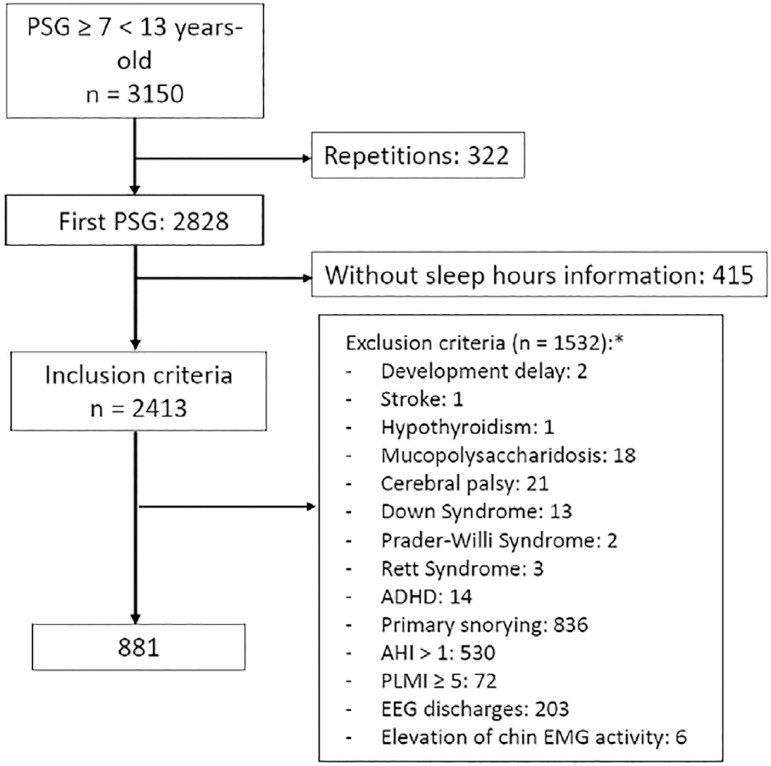
Enrollment flow. PSG = polysomnography, ADHD = Attention Deficit/Hyperactivity Disorder, AHI = apnea-hypopnea index, PLMI = periodic limb movement index, EEG = electroencephalography, EMG = electromyogram, * more than one condition is possible.